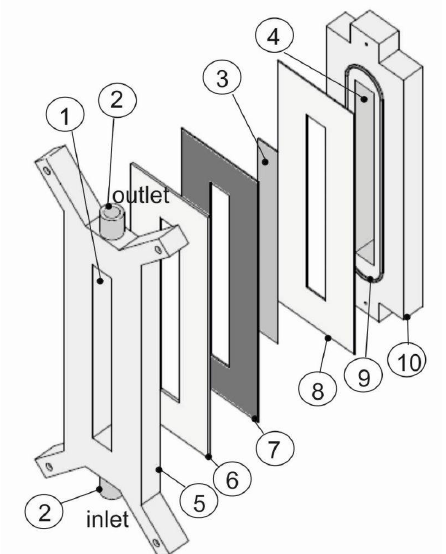
Fig. 2. Cross-sectional view of the test section, 1-a temperature measurement detection, 2-a thermocouple, 3-an enhanced heated plate, 4-a glass panel, 5-a front cover, 6, 8-a Teflon plate, 7-a graphite plate, 9-an o-ring, 10-a channel